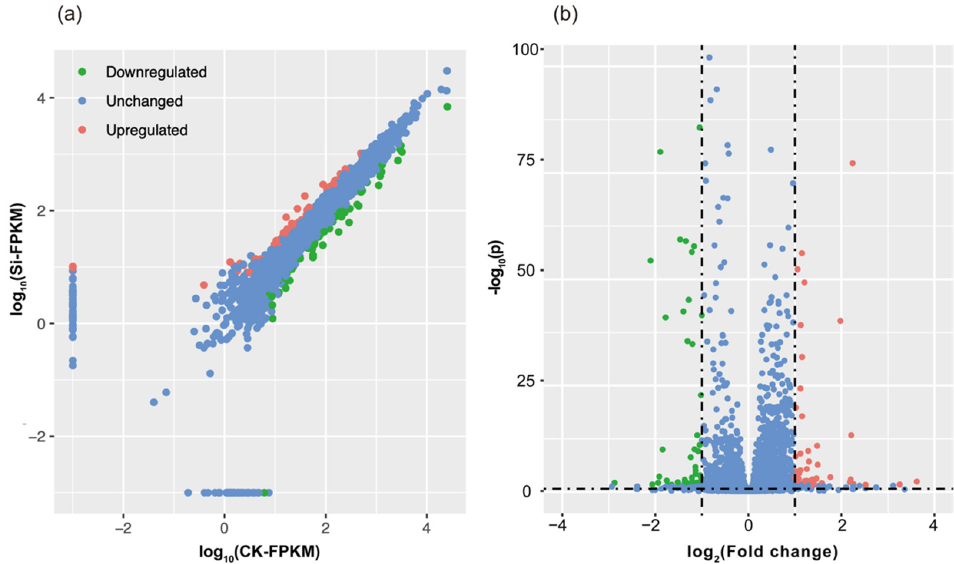
Figure 3. Gene expression changes and associated significant values across different treatments. Scatter plot ( a ) and volcano plot ( b ). Green dots represent significantly downregulated genes {Log 2 FPKM(Si)/FPKM(CK) > 2 and Log 10 FDR [FPMK (Si)/FPKM (CK)]) < 0.05}; red dots represent significantly upregulated genes {Log 2 FPKM(Si)/FPKM(CK) < − 2 and Log 10 FDR [FPMK (Si)/FPKM (CK)]) < 0.05}; blue dots represent no DEGs.